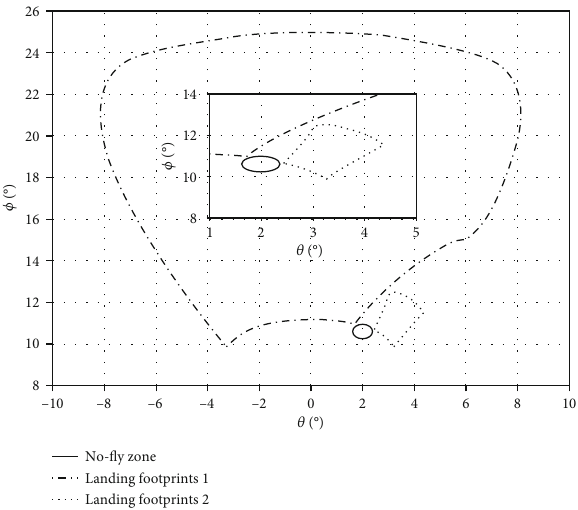
Figure 31: Landing footprints for Case 4.